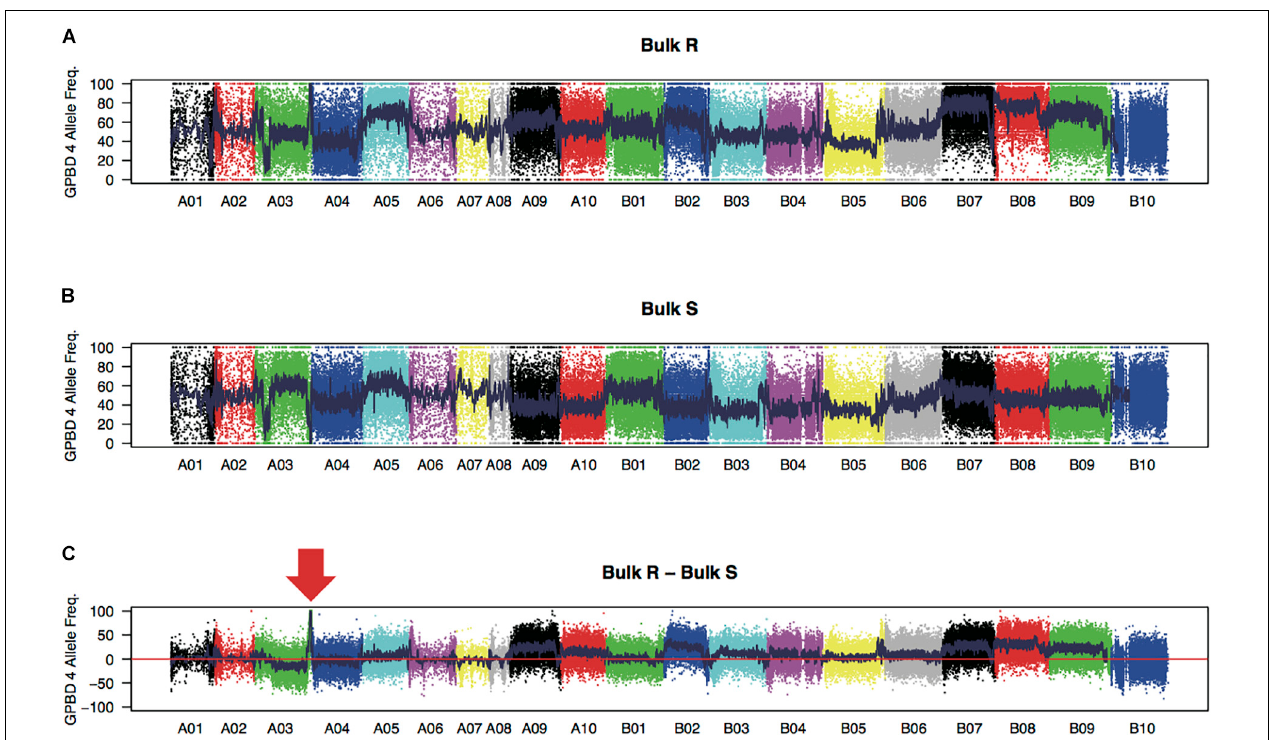
FIGURE 1 | SNP signals detected by bulked segregant analysis by sequencing. Frequencies of GPBD 4 alleles of genome-wide SNPs in bulk samples of rust-disease susceptible lines, bulk S (A) , and those of resistant lines, bulk R (B) , are plotted. Differences between the bulks R and S (bulk R – bulk S) are shown in (C) with an arrow indicating a prominent peak at the end of the chromosome A03. Twenty chromosomes were painted by different